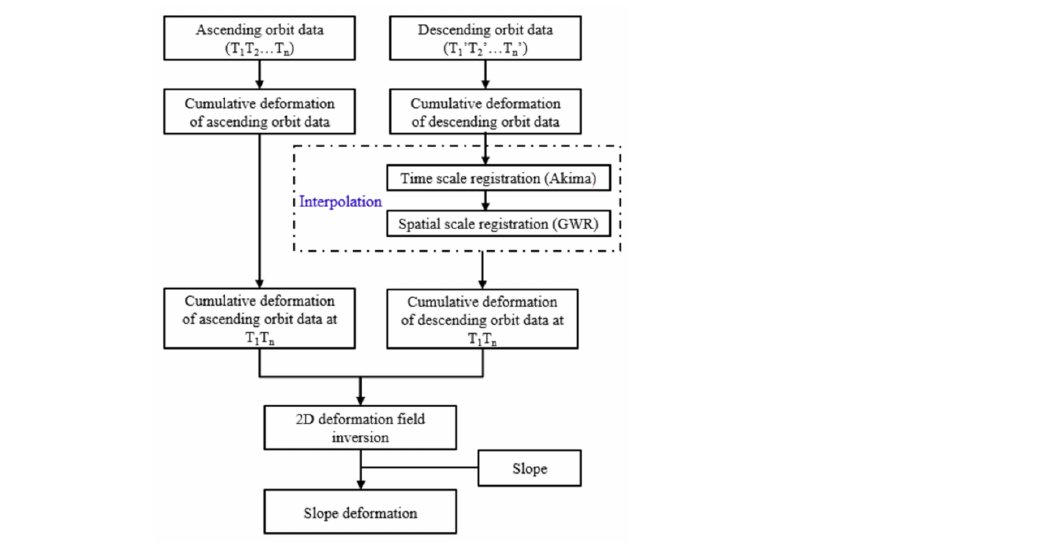
Figure 7. The technology flowchart of slope deformation extraction by ascending and descending orbit data